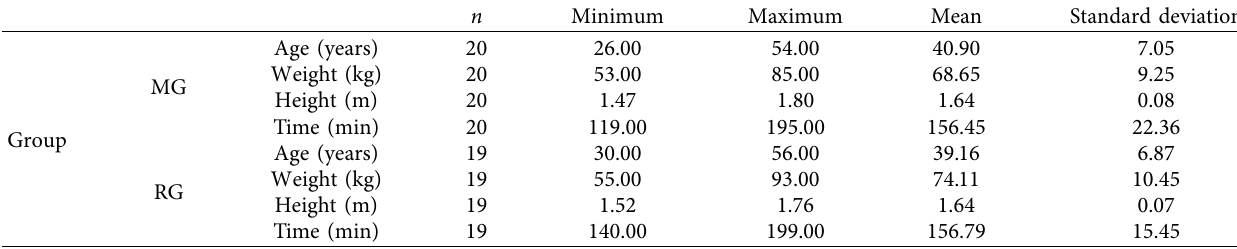
Table 1: Descriptive statistics for demographic variables.